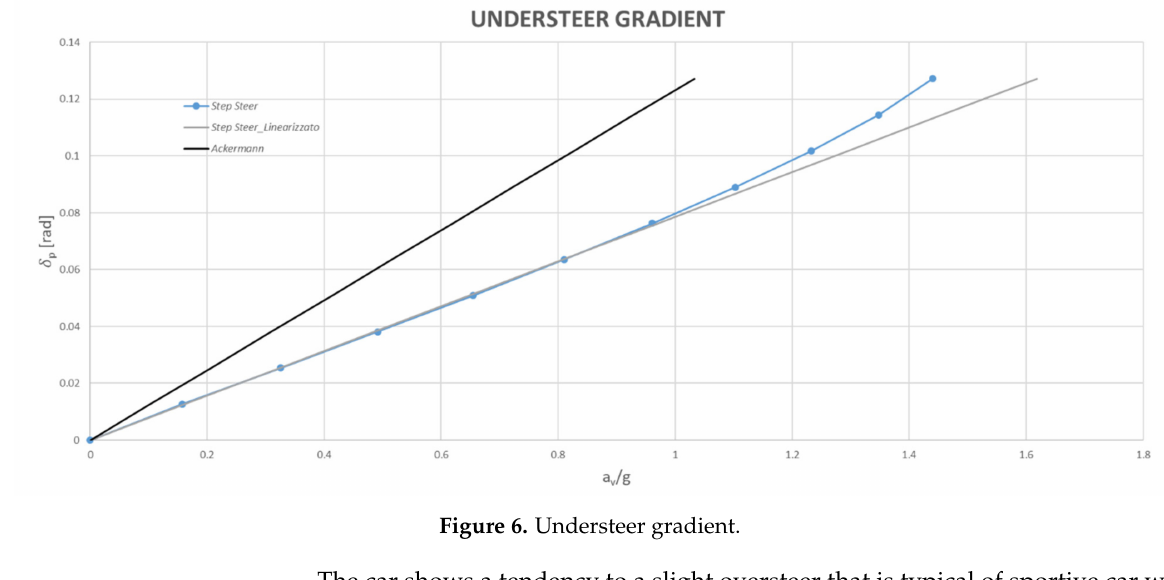
Figure 6. Understeer gradient.